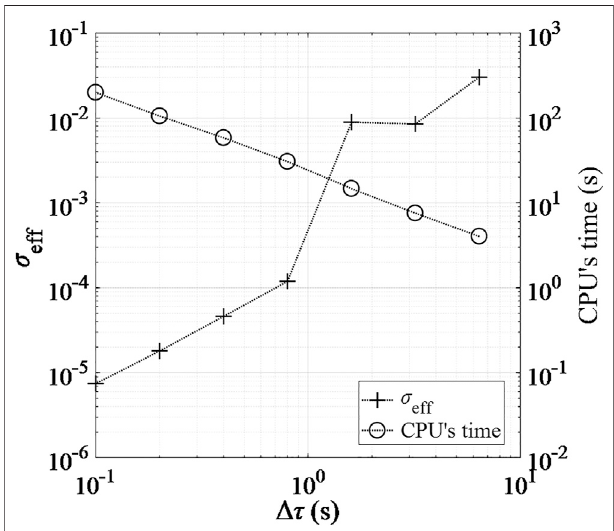
FIGURE 5 | Relative error σ eff and CPU time as functions of time step duration Δ τ